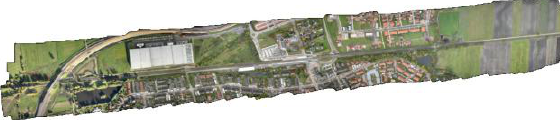
Figure 7 Orthomosaic of a metro station